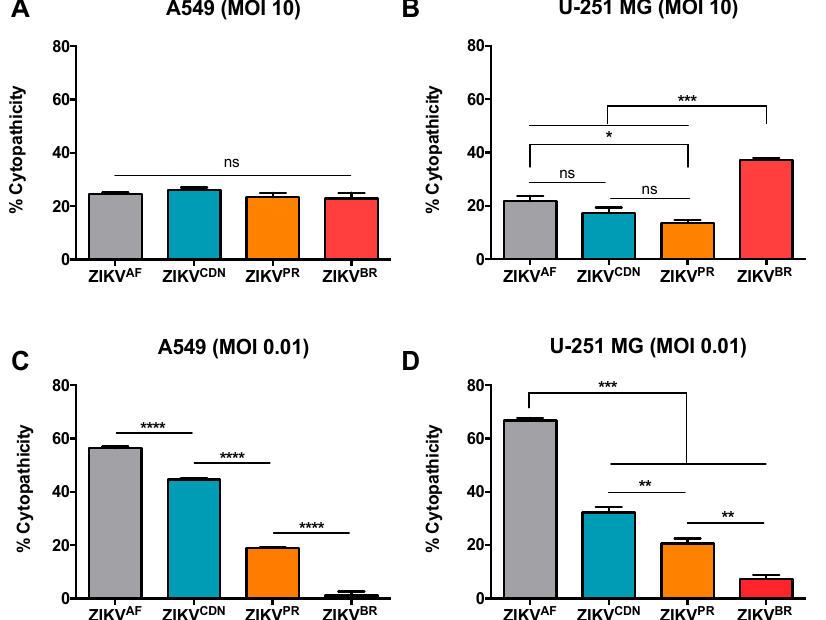
Figure 2. ZIKV isolates elicit different cytopathic effects in A549 and U-251 MG cell lines. ( A ) A549 and ( B ) U-251 MG cells were infected with ZIKV at MOI = 10 and cell viability was determined by MTT assay at 24 h post-infection. ( C ) A549 and ( D ) U-251 MG cells were infected with ZIKV at MOI = 0.01 and cell viability was determined by MTT assay 72 h post-infection. % Cytopathicity = 100% − ((Uninfected Absorbance − Infected Absorbance)/(Uninfected Absorbance) × 100%). Values represent the mean ± SEM of three independent experiments. Asterisks indicate significant differences in % cytopathicity: * p < 0.05, ** p < 0.01, *** p < 0.001, **** p <